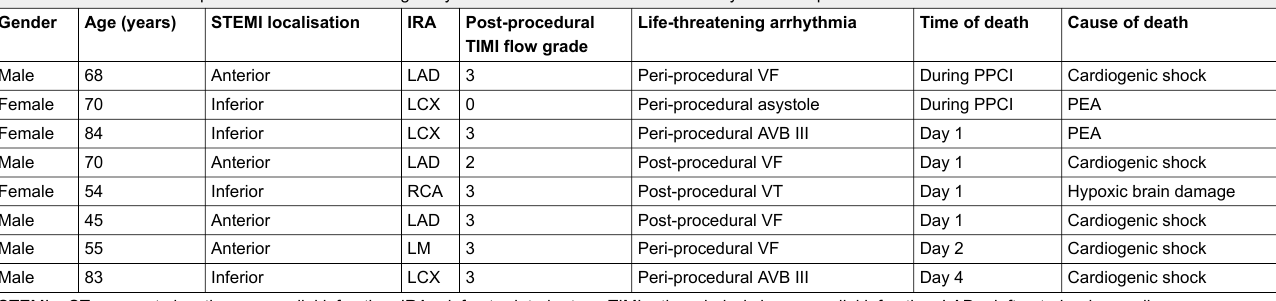
STEMI = ST-segment elevation myocardial infarction; IRA = infarct-related artery; TIMI = thrombolysis in myocardial infarction; LAD = left anterior descending coronary artery; LCX = left circumflex coronary artery; RCA = right coronary artery; LM = left main; VF = ventricular fibrillation; AVB III = third-degree atrioventricular block; VT = ventricular tachycardia; PPCI = primary percutaneous coronary intervention; PEA = pulse-less electrical